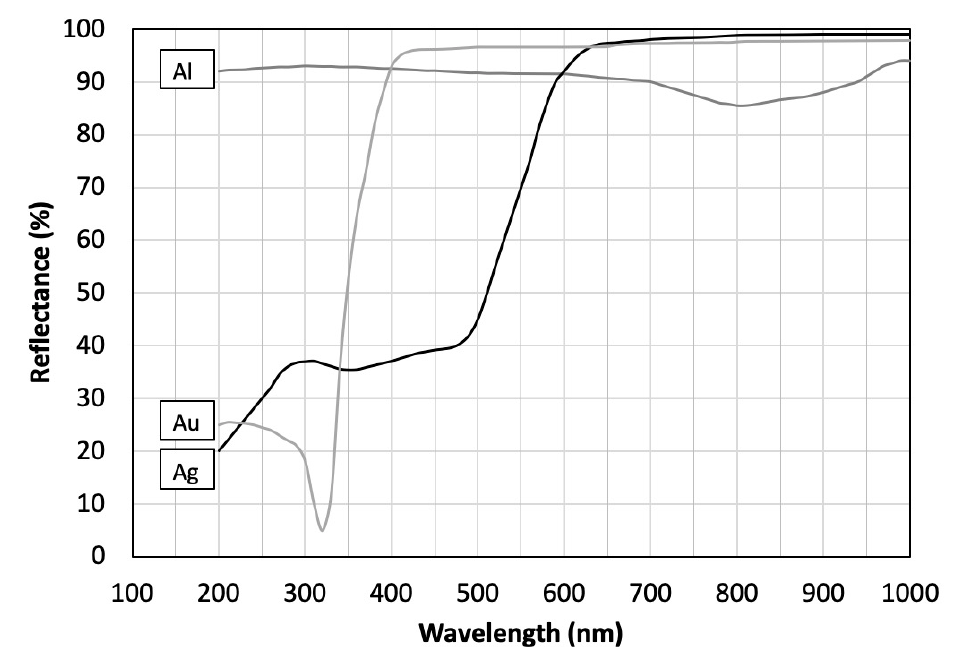
Figure 2. Reflectance of metal evaporated films coating of Ag, Al, and Au as function of wavelength (adapted from Hass et al., 1956) [24].